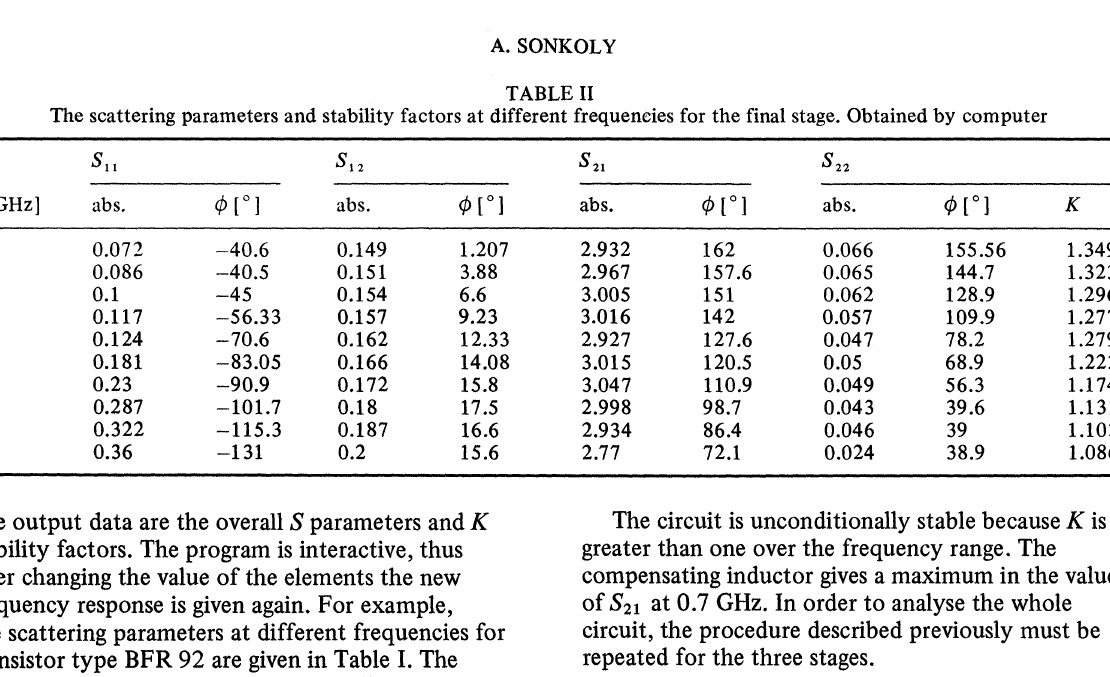
TABLE II The scattering parameters and stability factors at different frequencies for the final stage. Obtained by computer